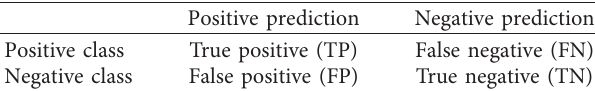
Table 1: Confusion